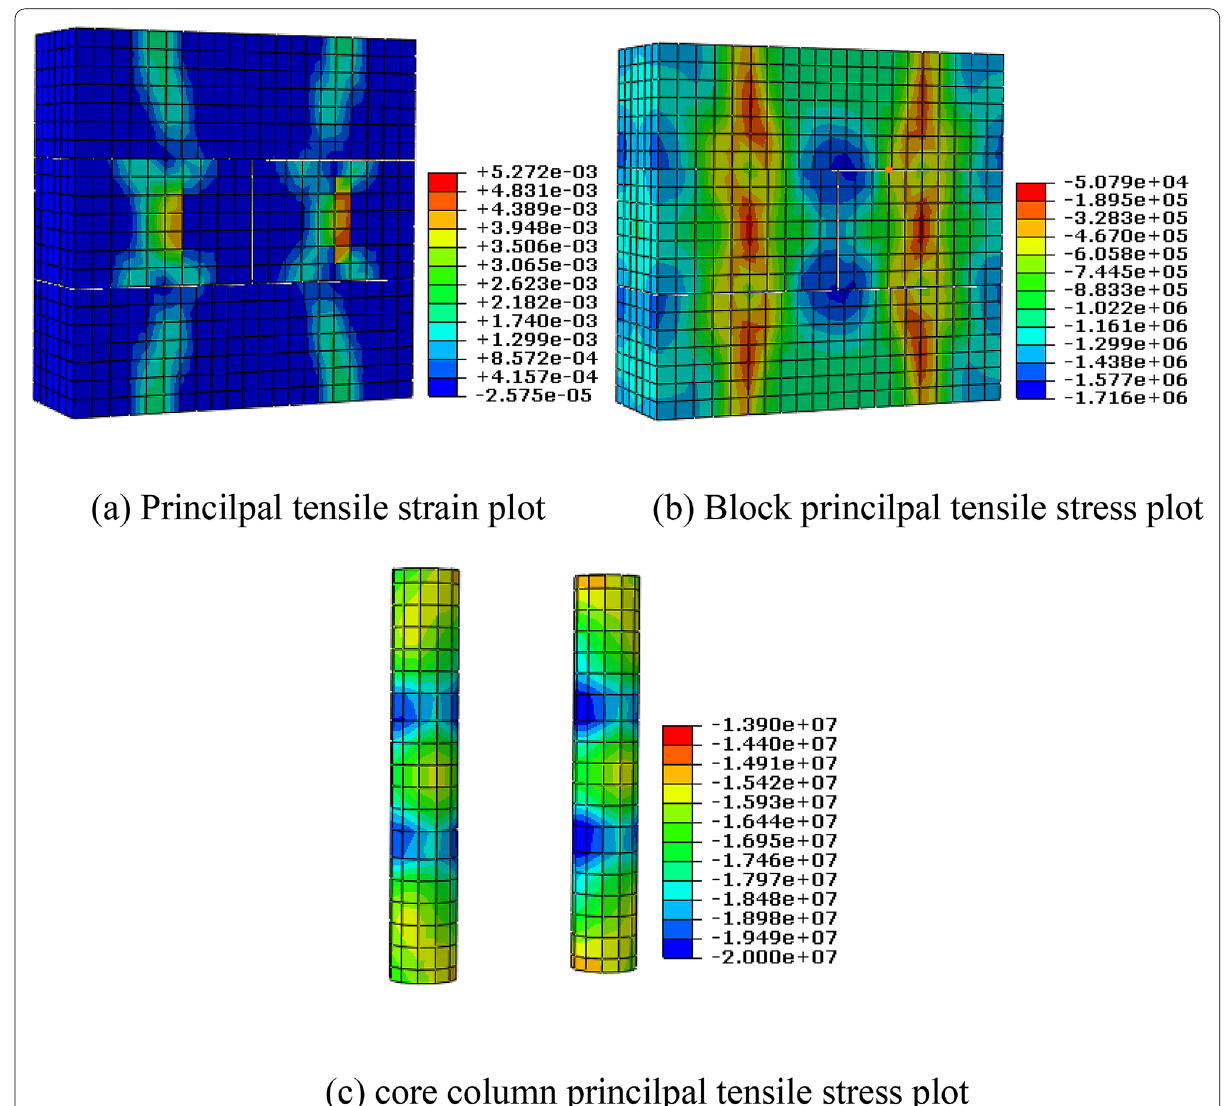
Fig. 14 Stress–strain plot of the peak load of CK1-1